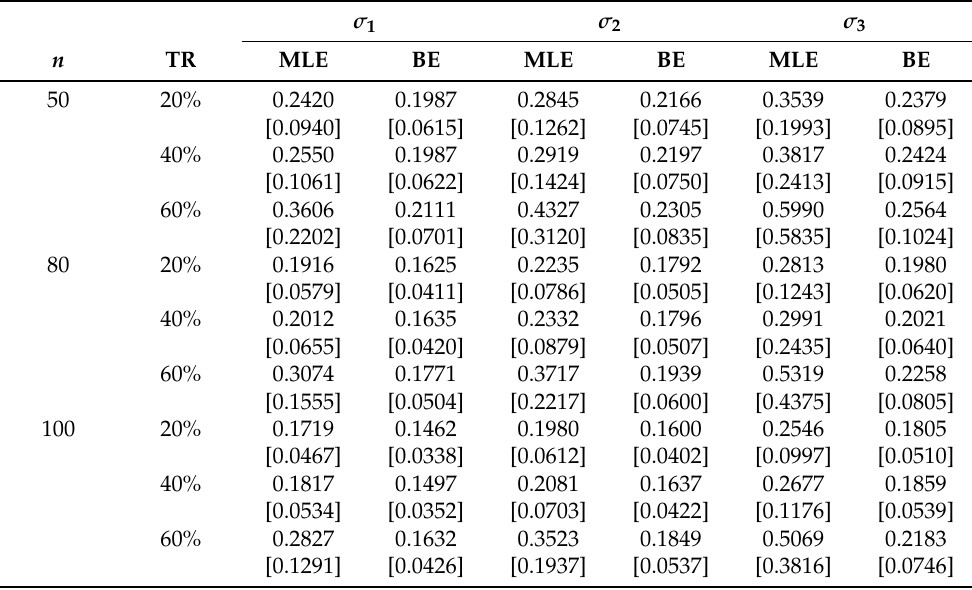
Table 2. ABs and MSEs (within bracket) for parameters without order restriction when ( σ 1 , σ 2 , σ 3 ) = ( 1,1.3,2 )